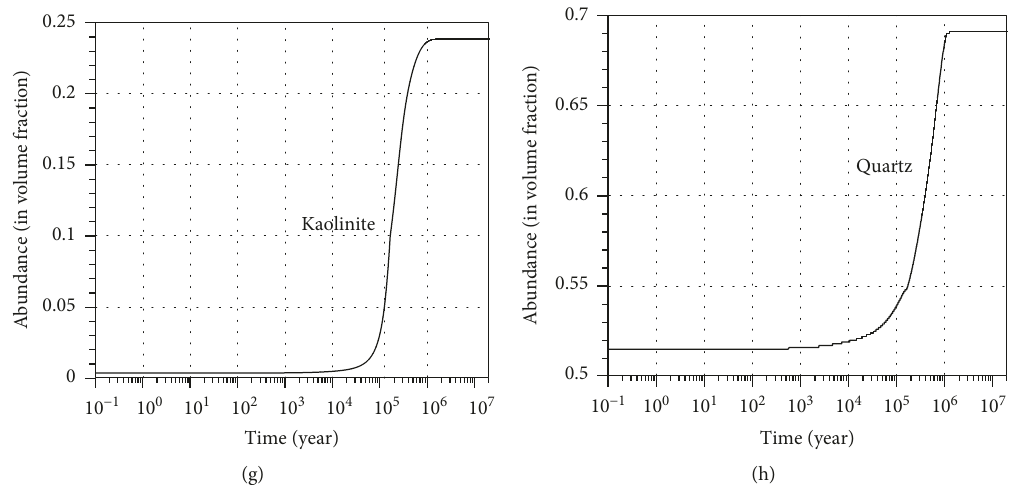
Figure 5: Variations in abundance (in volume fraction of medium) of albite and anorthite (a); K-feldspar (b); chlorite (c); illite (d); calcite, siderite, ankerite, and dawsonite (e); smectite-Na and smectite-Ca (f); kaolinite (g); and quartz (h) after fl ooding by CO